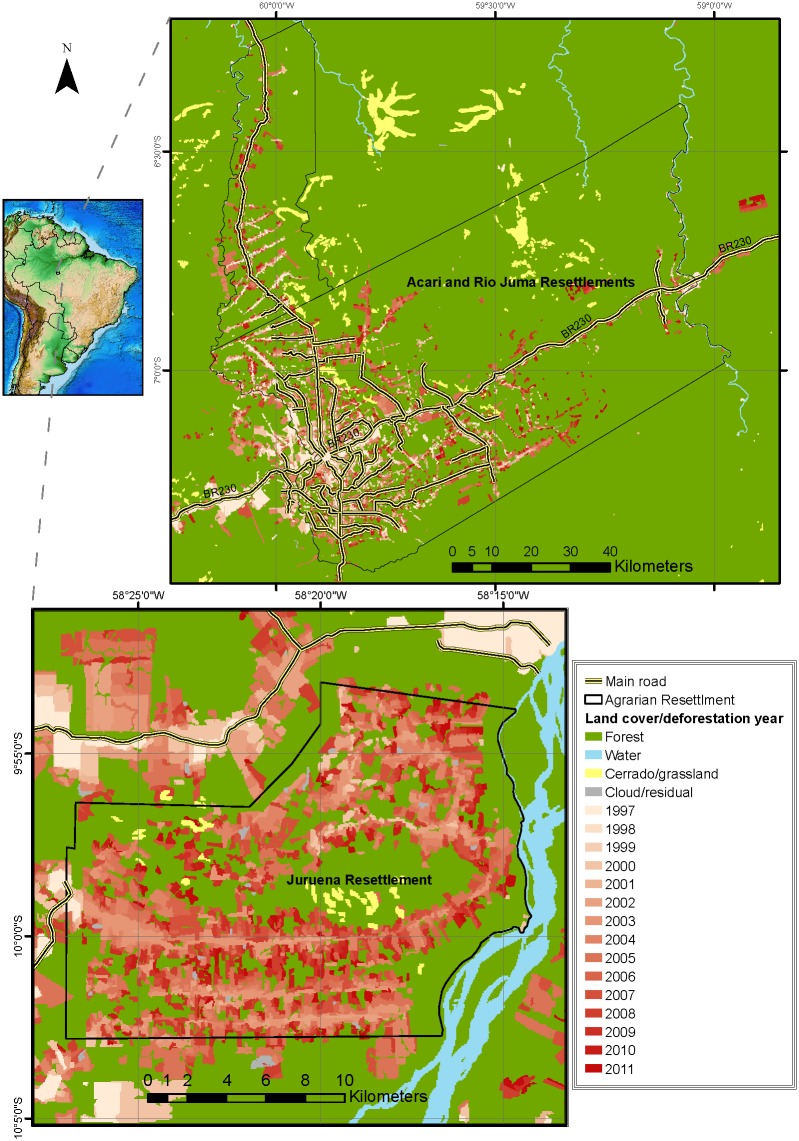
Annual deforestation polygons in selected settlements.Examples of land cover change within three INCRA settlements of the Brazilian Amazon. The Rio Juma and Acari Settlements (top) were created in 1981 and 1982, respectively, far from the southern Amazonian agricultural frontier, whereas the more recent Juruena Settlement (created in 1997) lies in a vibrant deforestation hotspot of the northern state of Mato Grosso. These settlement polygons had experienced very little loss in forest cover prior to the arrival of settlers, as indicated by the color-coded deforestation chronosequence (where darker colors indicate more recent deforestation).